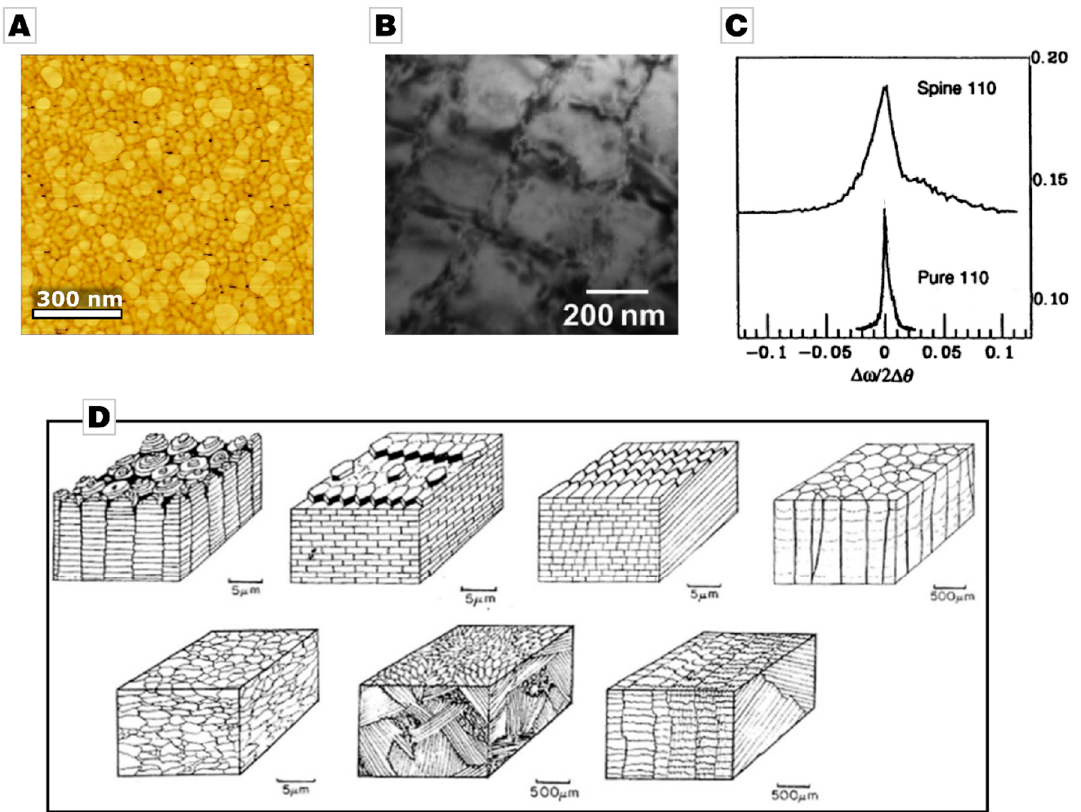
Figure 2. Structural organization of biominerals in bivalves. ( A ) Atomic force microscopy (AFM) phase image of Glycymeris glycymeris treated with EDTA. Reproduced from ref. [81], reproduced with permission. ( B ) TEM image of Pinctada fucata. Reprinted with permission from ref. [92]; copyright (2012) American Chemical Society. ( C ) XRD di ff ractogram of a macroscopically single-crystalline sea urchin spine and pure calcite demonstrating Debye-Scherrer broadening of the biocrystal. Reprinted from ref. [95]; reprinted with permission from AAAS. ( D ) Seven di ff erent microstructures in bivalves and gastropods: Columnarnacre, sheetnacre, foliated, prismatic, crossed-lamellar, complexcrossed-lamellar, and homogenous. Reprinted from ref. [103] with permission from John Wiley and